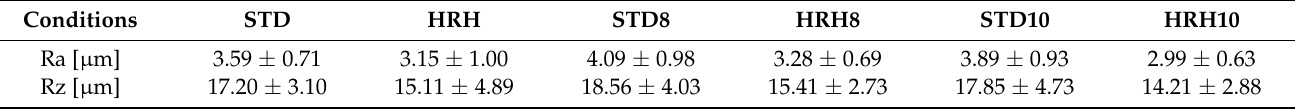
Figure 6. Moisture content of cores depending on the time of storage under different storage condi- tions (different shooting pressures used within the core production): STD—Laboratory ambient con- ditions—RH = 60% ± 5%, t = 25 °C, Shooting pressure 6 bar; STD8—Laboratory ambient conditions— RH = 60% ± 5%, t = 25 °C, Shooting pressure 8 bar; STD10—Laboratory ambient conditions—RH = 60% ± 5%, t = 25 °C, Shooting pressure 10 bar; HRH—High relative humidity, constant tempera- ture—RH = 90% ± 5%, t = 25 °C, Shooting pressure 6 bar; HRH8—High relative humidity, constant temperature—RH = 90% ± 5%, t = 25 °C, Shooting pressure 8 bar; HRH10—High relative humidity, constant temperature—RH = 90% ± 5%, t = 25 °C, Shooting pressure 10 bar.